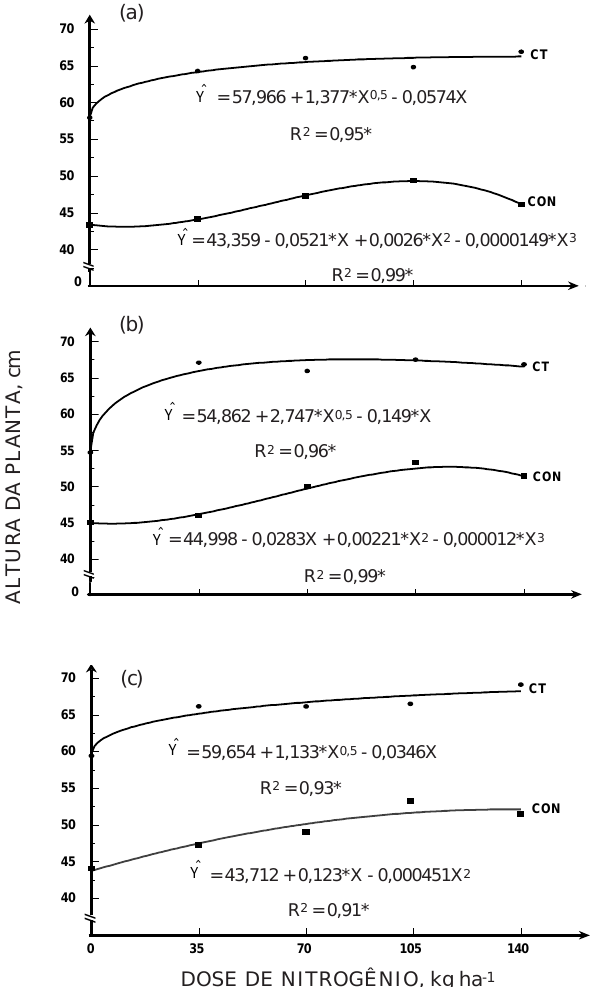
Figura 1 . Altura de plantas de alho provenientes de cultura de tecidos (CT) e multiplicação convencional (CON), 90 (a), 110 (b) e 130 (c) dias após o plantio, considerando as doses de nitrogênio. *, ** significativos a 5 e 1%, respectivamente, pelo teste